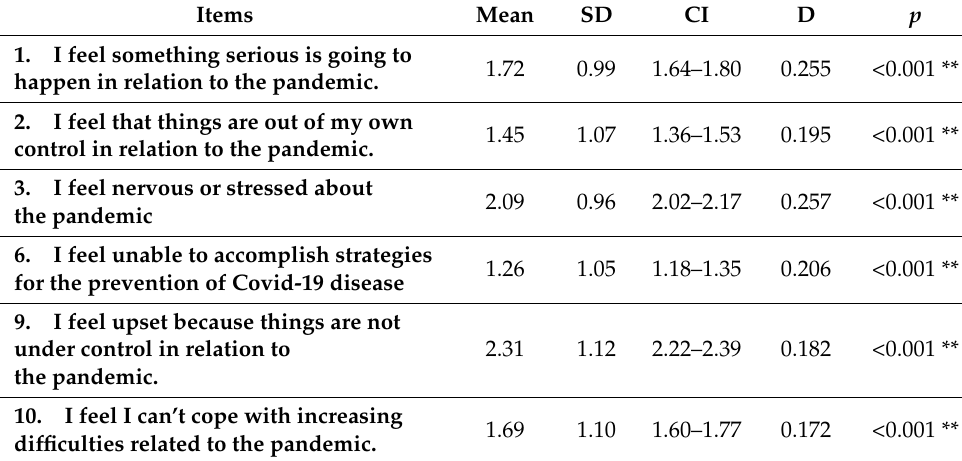
Table 3. Items related to negative perceptions reported by respondents during the ‘third wave’ of the COVID-19 pandemic in